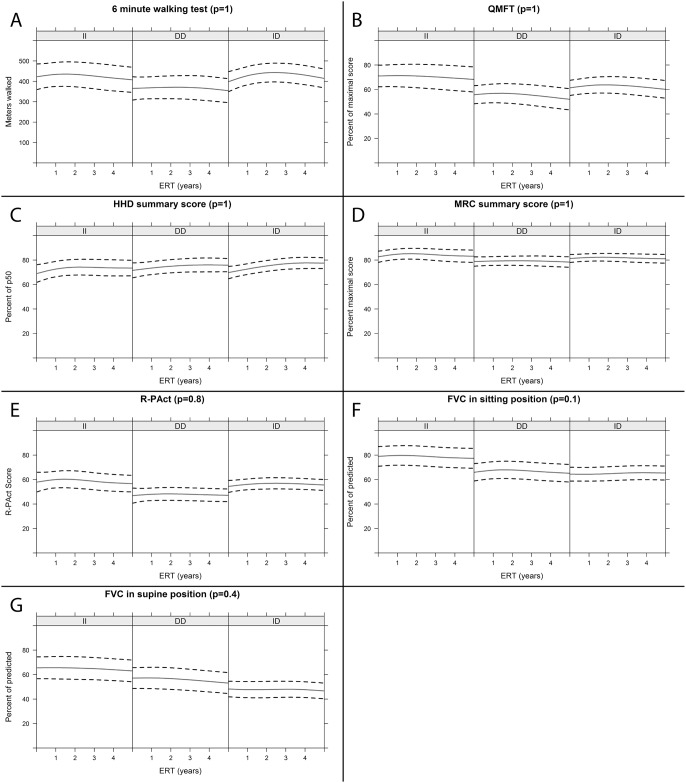
Predicted group means for outcome measures over 5 years of ERT treatment.Group means (continuous line) of the outcome measures and 95% prediction interval (area between the dotted lines) obtained for the II, ID and DD genotypes using linear mixed models. P values are indicated in the titles above the graphs.